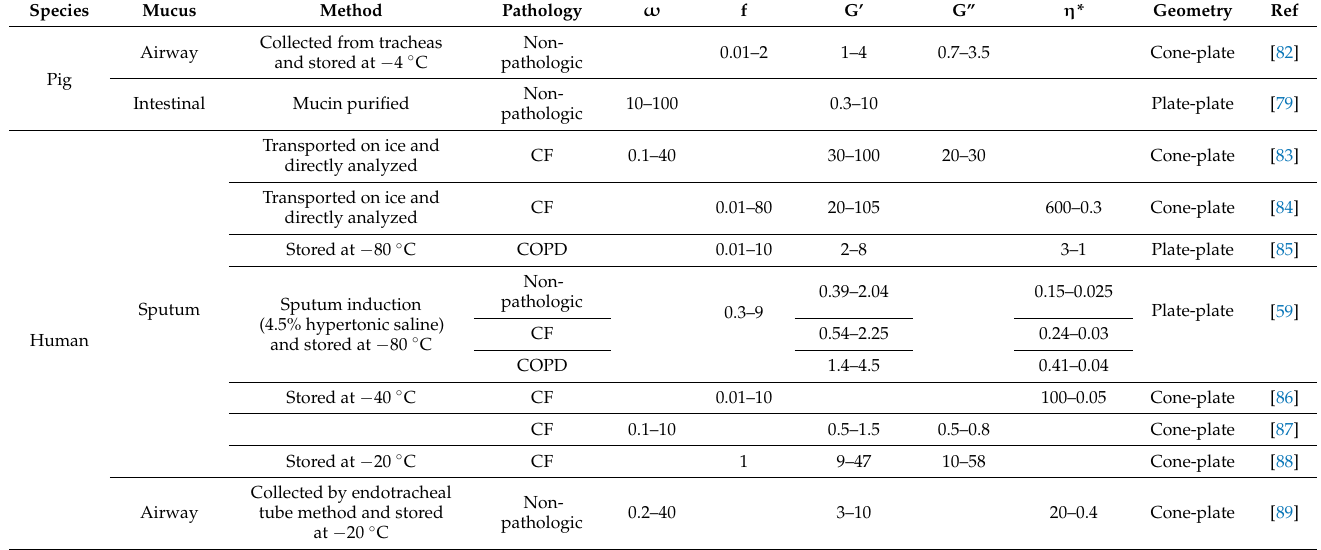
Table 1. Example of different sources of mucus and their oscillatory shear viscoelastic properties. ω , angular frequency (rad/s); f, frequency (Hz); G’, storage modulus (Pa); G”, loss modulus (Pa); η *, complex viscosity.